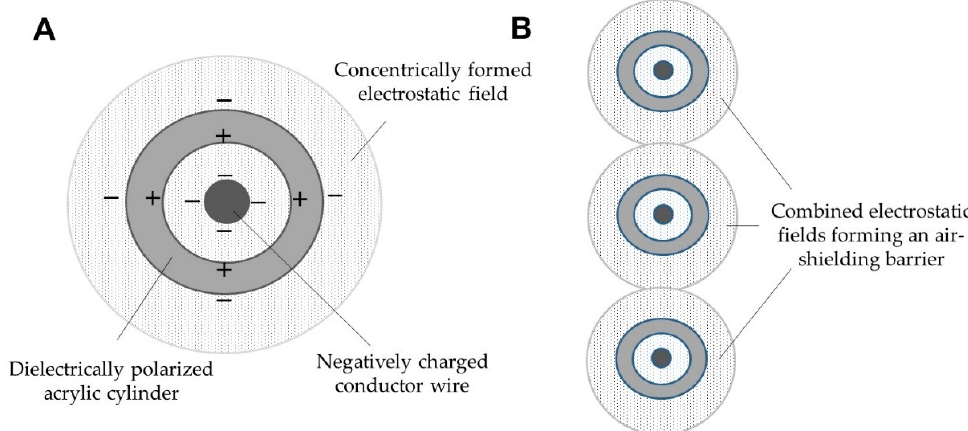
Figure 1. Schematic representation of the electrostatic field produced by a negatively electrified insulator (acrylic cylinder) covering a negatively charged conductor (iron wire) ( A ) and insulated conductor wires in a vertical array forming an air-shielding barrier of combined electrostatic fields (cross-sectional view) ( B ).